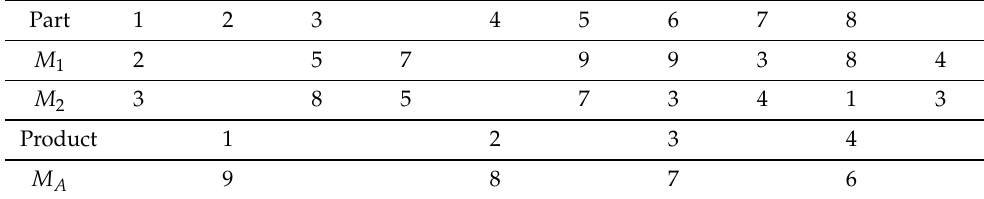
Table 1. Machining time for parts and